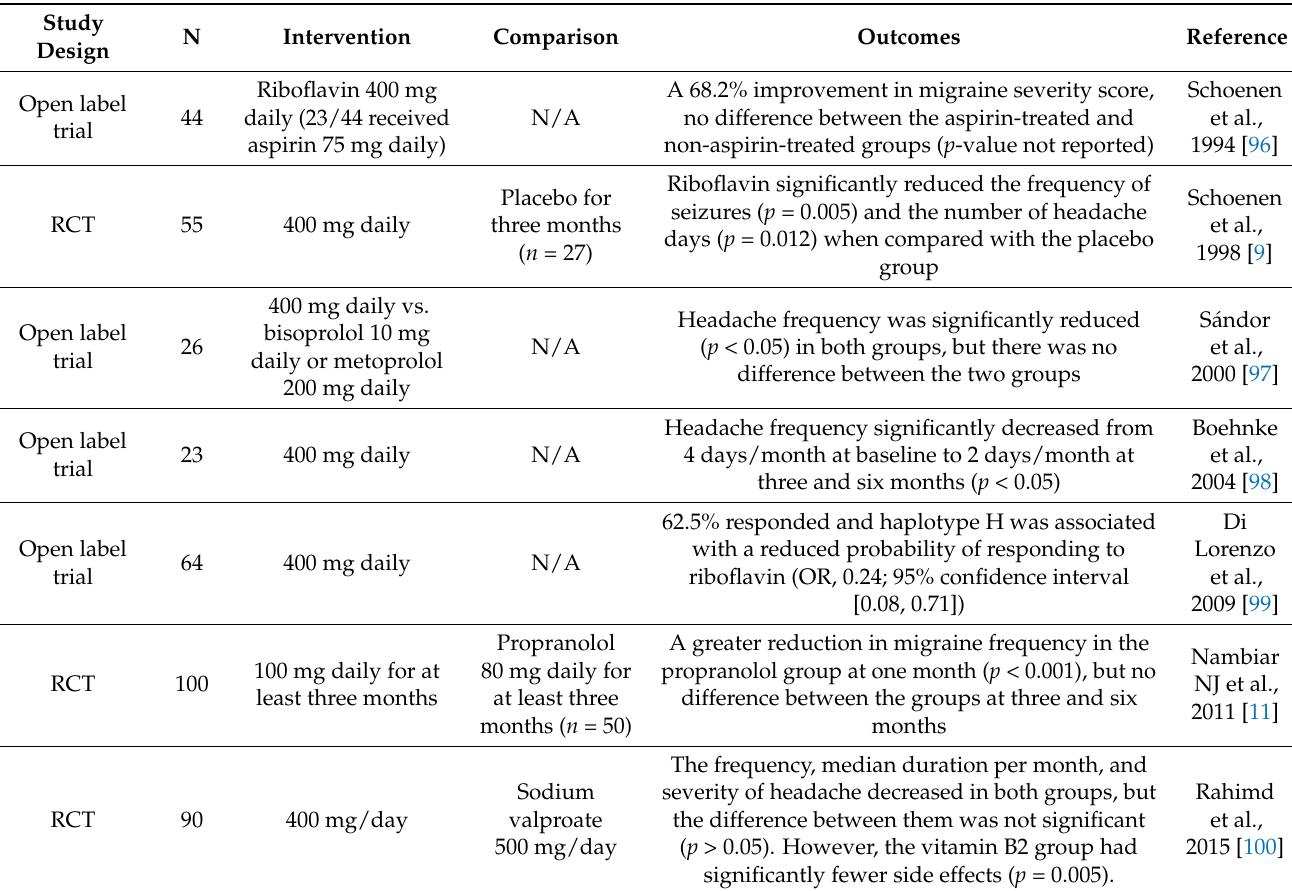
Table 3. Summary of studies on riboflavin for adult